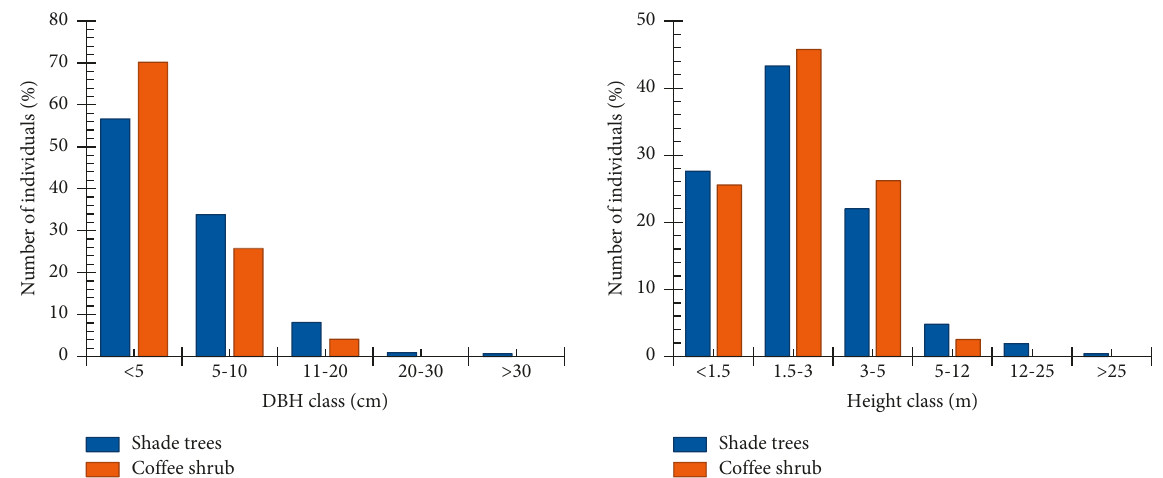
Figure 3: Diameter (DBH) and height class distribution of shade tree species and coffee shrub in coffee-based agroforestry (Table 4). Throughout the coffee-based agroforestry system Vernonia amygdalina , Millettia ferruginea , and Cordia af- ricana were the shade tree species that have the highest density (307, 299, and 165 tree ha − 1 , respectively) (Table 4).